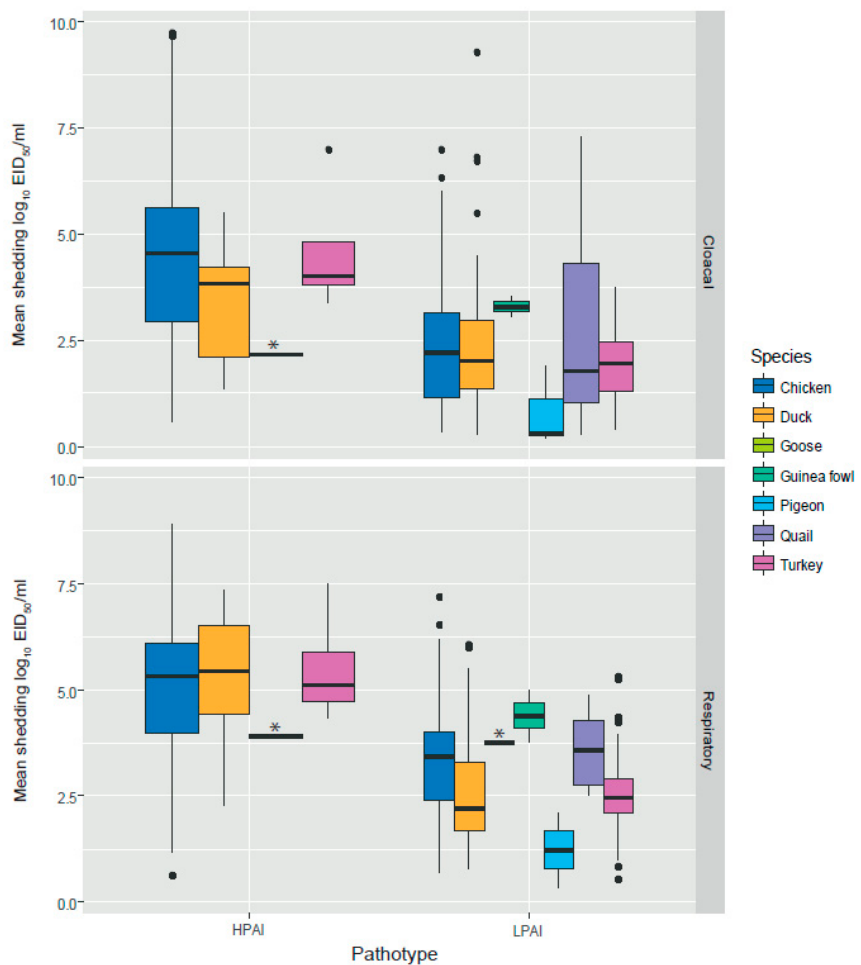
Figure 3. Distribution of mean shedding levels (log 10 EID 50 / mL) in respiratory and cloacal swabs of highly pathogenic avian influenza (HPAI) virus and low pathogenic avian influenza (LPAI) virus distributed by species. The box represents the first quartile, the median (band inside the box) and the third quartile. Individual black dots are outliers. * indicates goose data (box is not visible because there was only one observation).